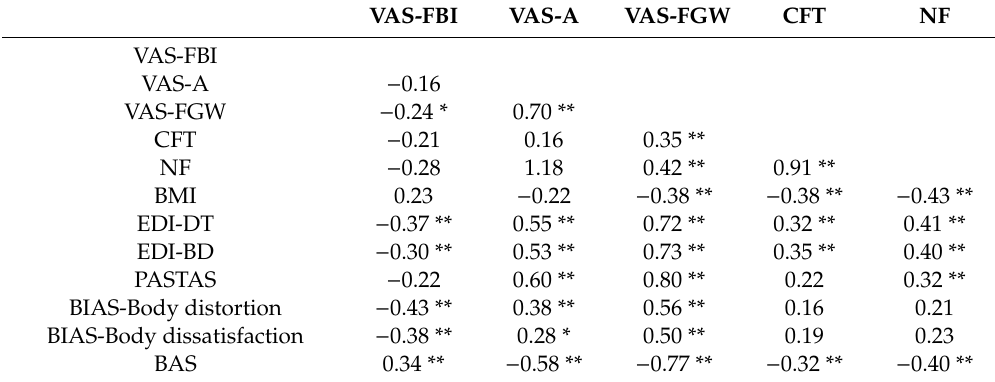
Table 3. Correlations between eating disorder (ED) measures and virtual reality (VR) body exposure responses in the entire sample.